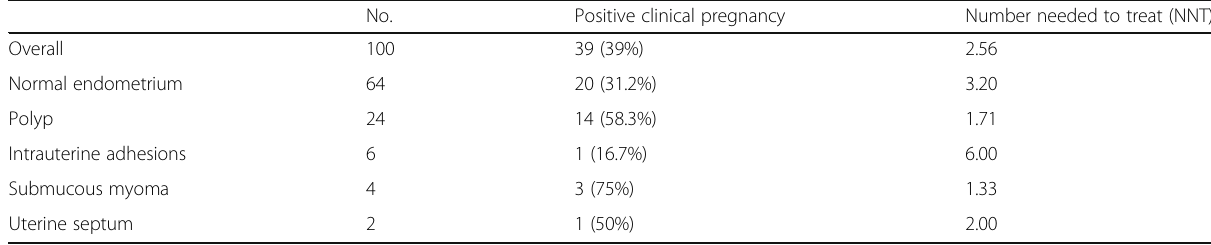
Table 3 Impact of hysteroscopy and hysteroscopic intervention on clinical pregnancy outcome in repeat IVF/ICSI cycle No. Positive clinical pregnancy Number needed to treat (NNT)